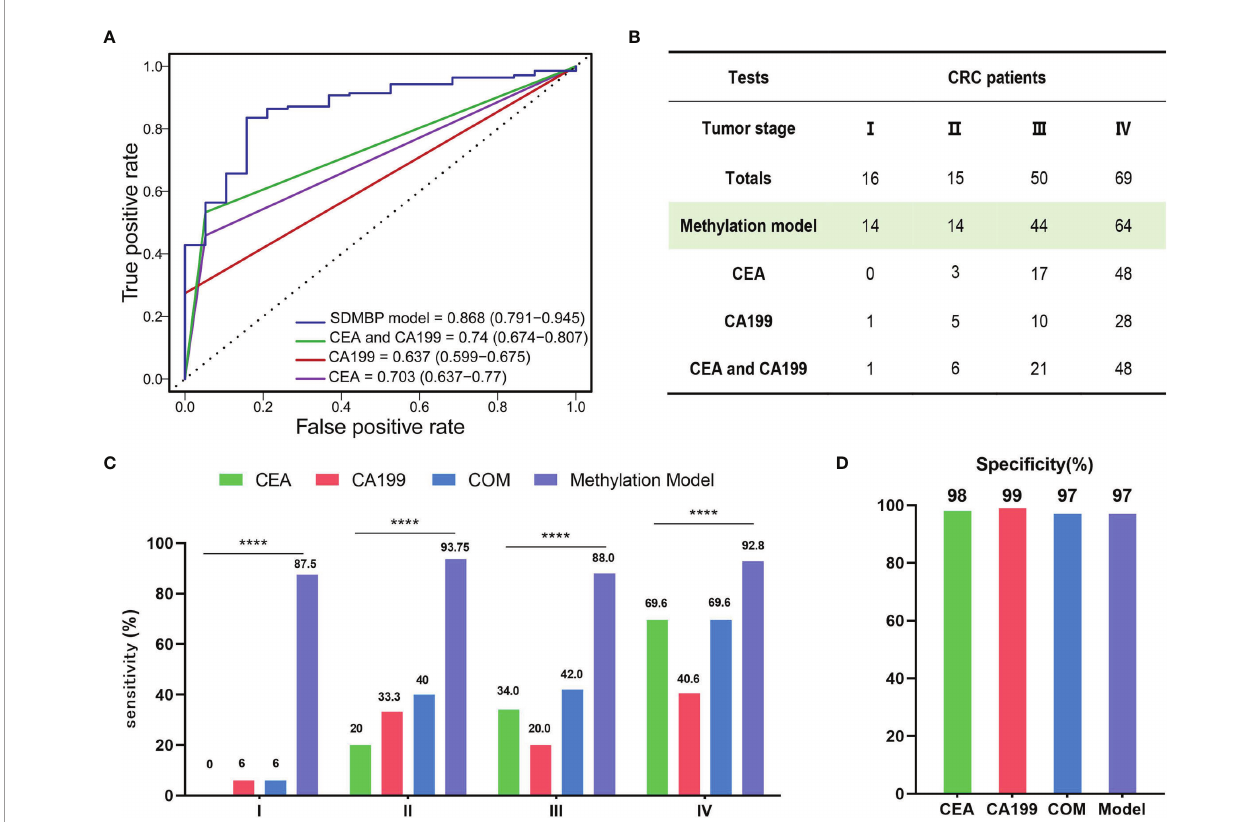
FIGURE 5 | Comparison of the SDMBP model with quanti fi cation of the levels of serum CEA and CA199 for diagnosing CRC. (A) ROC curves and corresponding AUCs of the SDMBP model, the CEA level, the CA199 level and the combination of the levels of CEA and CA199 for diagnosing CRC in the validation dataset; (B) The diagnostic ef fi ciency comparison of the SDMBP model, the CEA level, the CA199 level and the combination of the levels of CEA and CA199 for discriminating AA from CRC of different TNM stages in the validation dataset; (C, D) Sensitivity and speci fi city comparison of the SDMBP model, the CEA level, the CA199 level and the combination of the levels of CEA and CA199 in CRC patients with different TNM stages in the validation dataset. Statistical signi fi cance was assessed by the c 2 test (C) . ****P <